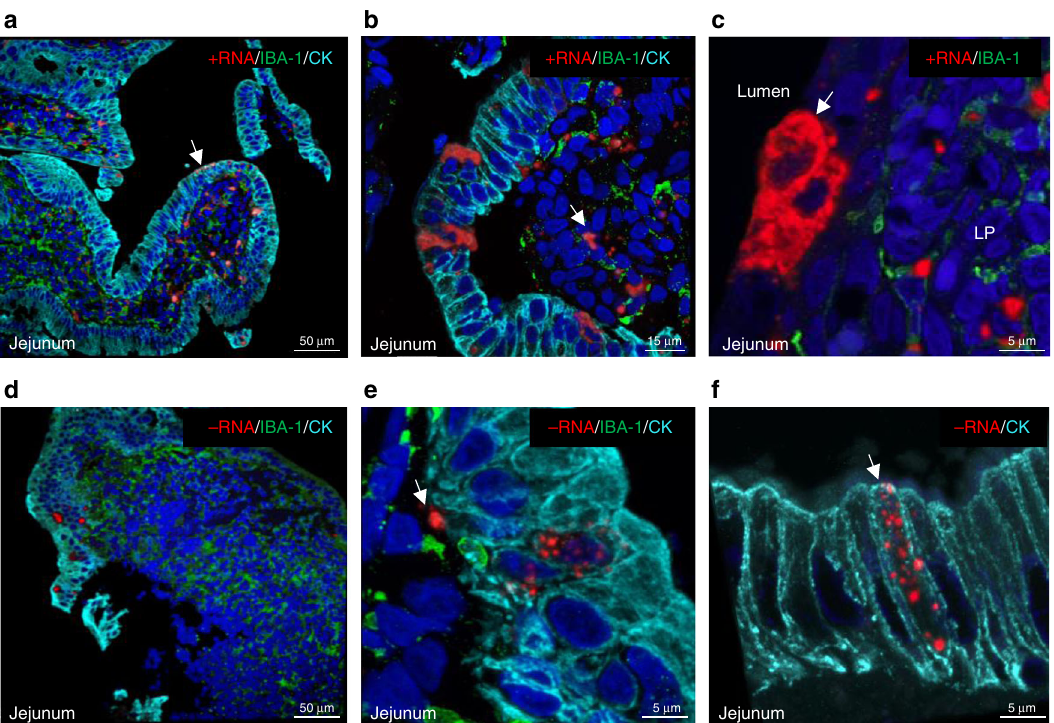
Fig. 2 Positive and negative-sense norovirus RNA differ in distribution and intensity in GT-1 jejunal biopsies. The GT-1 biopsy was analyzed by ISH with RNAscope norovirus-speci fi c probes to detect: a – c positive strand RNA ( + RNA) or d – f negative-strand RNA (-RNA). Characteristic distribution patterns of the different RNA species (red) are highlighted by white arrows and described in the text. The negative-sense RNA signal marked by the arrow in panel e was rendered in a 3D format with the Imaris Software package (Supplementary Movie 1). Cells in the epithelial layer were visualized by antibodies to detect cytokeratin (CK) (cyan) and those in the LP were represented by the detection of macrophage with marker IBA-1 (green). Nuclei are stained with DAPI